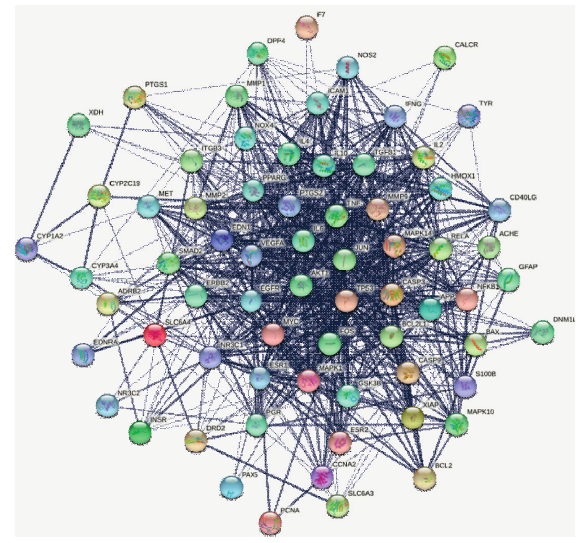
Figure 3: Network of interactions between proteins.